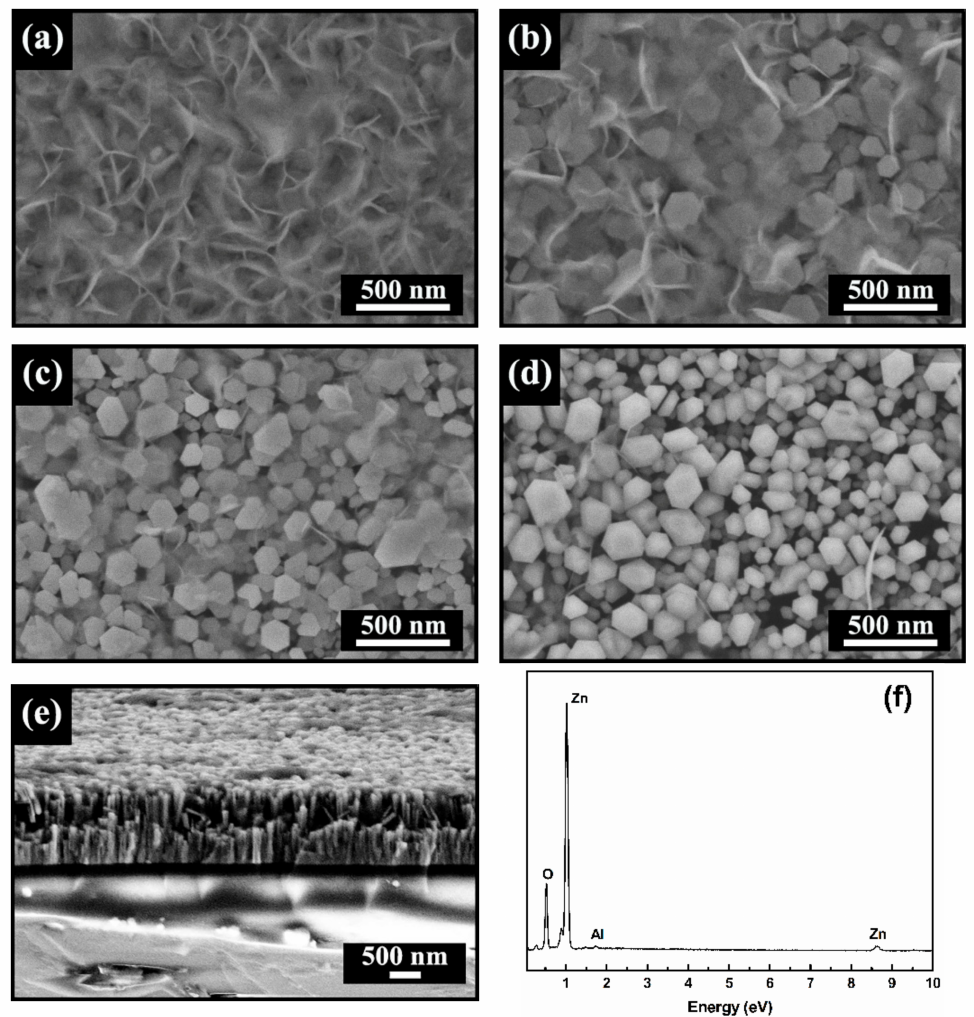
Figure 2. Top view SEM images of the single-textured AZO films prepared at different growth temperatures: ( a ) 70 ◦ C, ( b ) 80 ◦ C, ( c ) 90 ◦ C, and ( d ) 100 ◦ C. ( e ) Cross-sectional view SEM image of the T-100 ◦ C sample. ( f ) EDX spectrum of the T-100 ◦ C